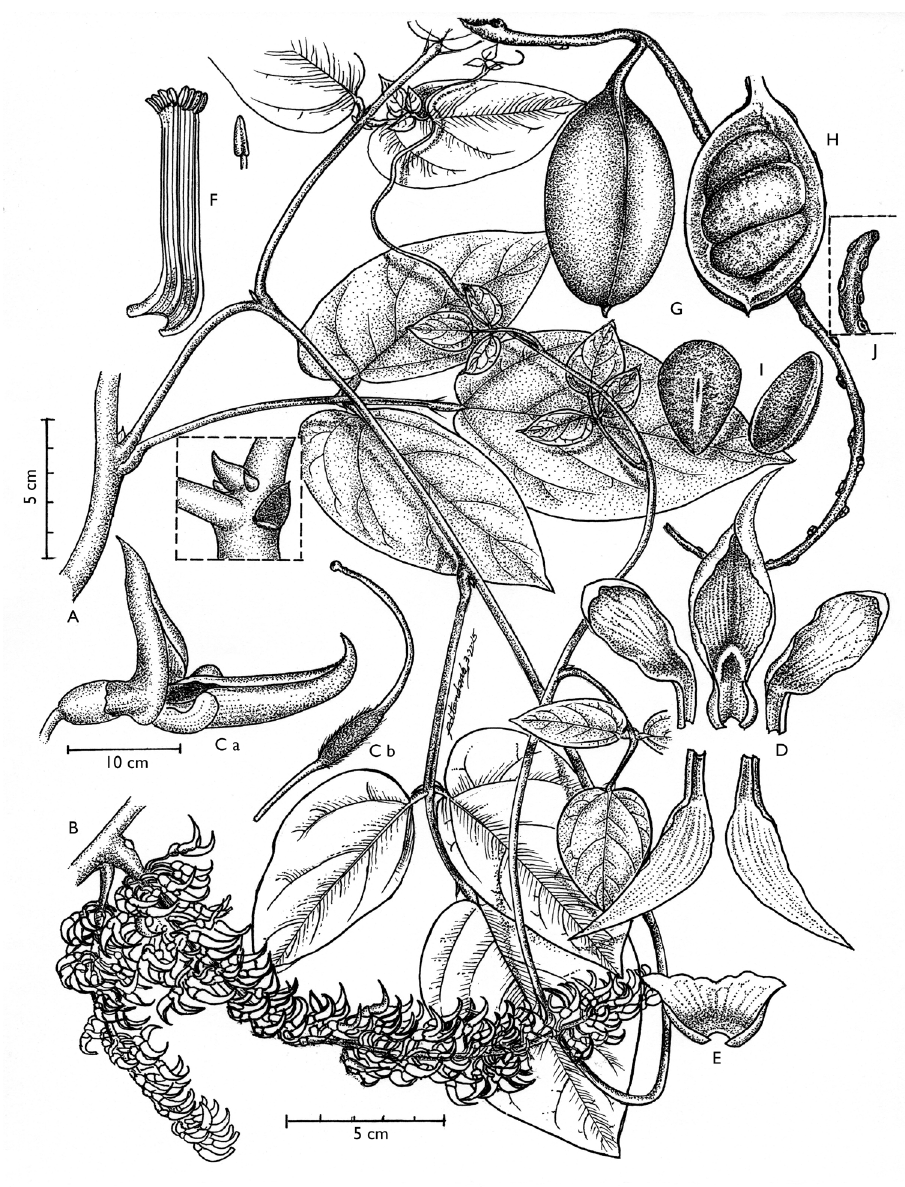
Figure 2. Strongylodon juangonzalezii sp. nov. A growth habit, inset shows the distinct middle and lateral stipules B portion of a flowering branch C Detached flower D dissected flower E calyx F androecium and anther G intact pod H pod opened to show the seeds I seeds, front and side view J